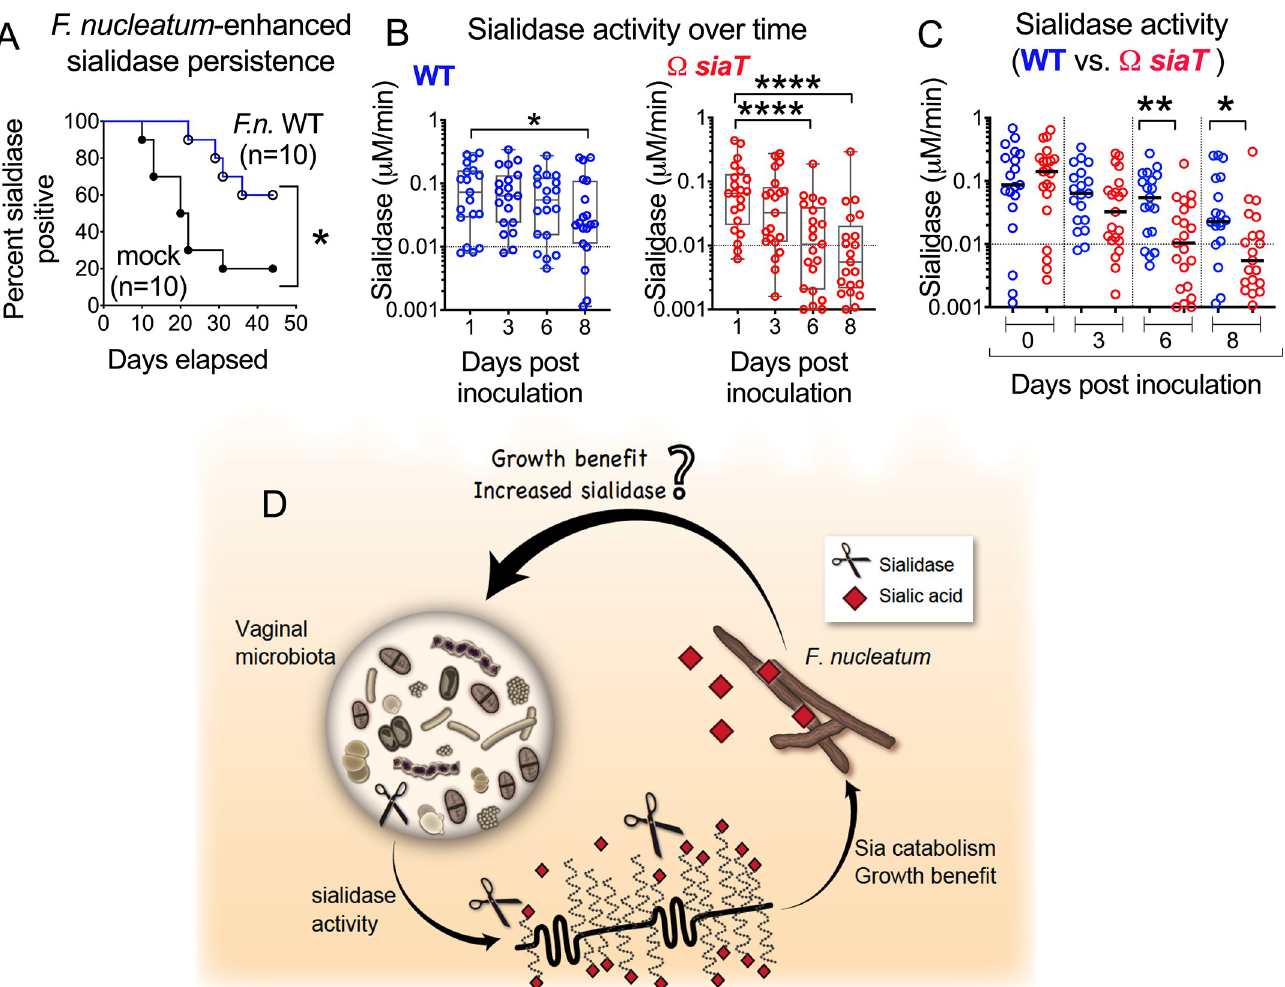
Fig 5. Microbiota-derived sialidase activity in the mouse vagina is sustained by F . n . colonization. (A) Persistence of sialidase activity in C57BL/6 mice (Envigo) inoculated either with WT F . n . or vehicle only. Mice were considered sialidase-negative if sialidase activity levels in vaginal washes were below 0.01 μ M/min (using the 4MU-Sia assay) for 3 sequential time points. Data are shown from a single experiment with a total of N = 20 animals. � P < 0.02, log–rank test. (B–C) Sialidase activity in vaginal washes from 1 to 8 dpi from individual animals purchased from Envigo, estrogenized, and inoculated with either WT or O siaT F . n . The graphs represent combined data from 2 independent experiments, with 10 mice per group in each experiment. Data points with negative values were set to 0.001 to represent them on the log scale. (B) Sialidase activity at later time points were compared to day 1 values using the Friedman test, with correction for multiple planned comparisons using Dunn’s test. (C) Same experiment and data as shown in B but analyzed to compare between WT- or O siaT -inoculated animals at each time point using the Mann–Whitney test. On all graphs, � P < 0.05, �� P < 0.01, ���� P < 0.0001. (D) Sialidase producers in the vaginal microbial community release free sialic acids (red diamonds) from host glycoconjugates, providing benefits to F . n . Hypothesis: at the same time, vaginal community members themselves derive benefits from F . n ., leading to sustained sialidase activity in these communities. Sialidases are represented as scissors. The underlying numerical data for this figure can be found in S1 Data. dpi, days postinoculation; F . n ., F . nucleatum ; siaT , predicted sialic acid transporter; WT, wild type; 4MU,